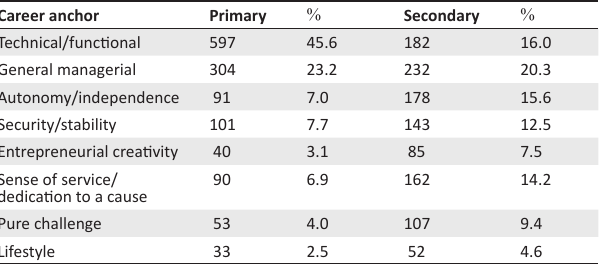
TABLE 10: Primary and secondary career anchors in the short term (1 to 3 years). Career